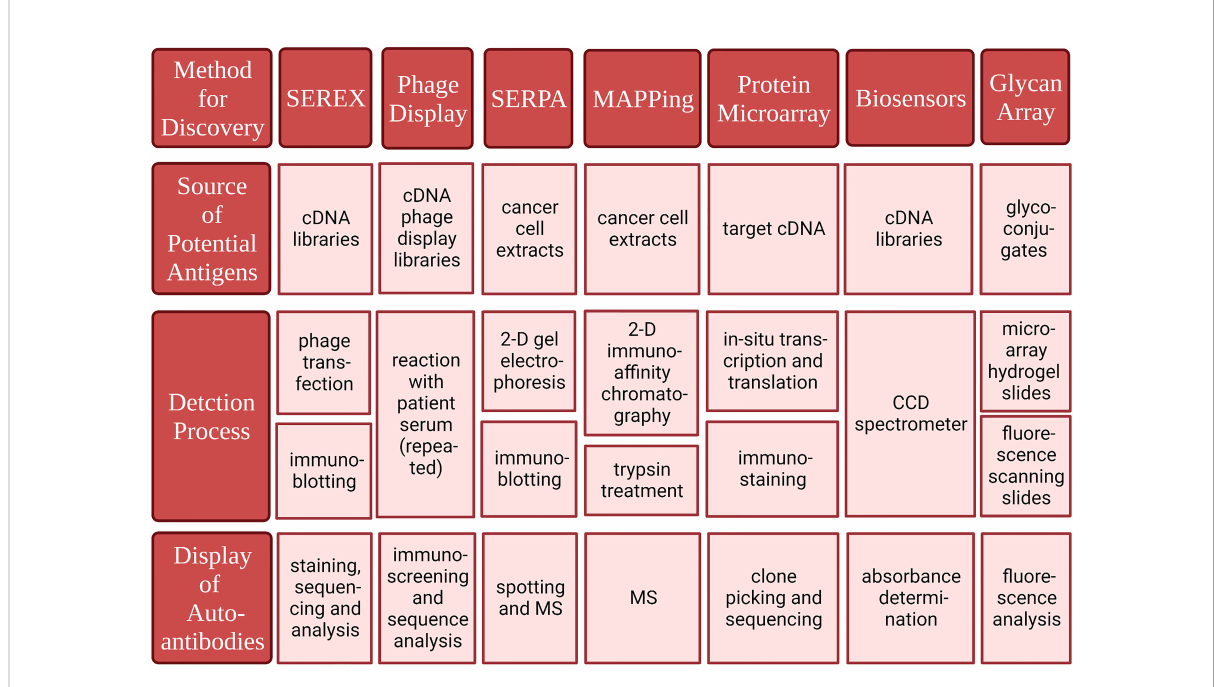
FIGURE 3 Methods for identifying tumor-associated antigens and correlated autoantibodies. Created with